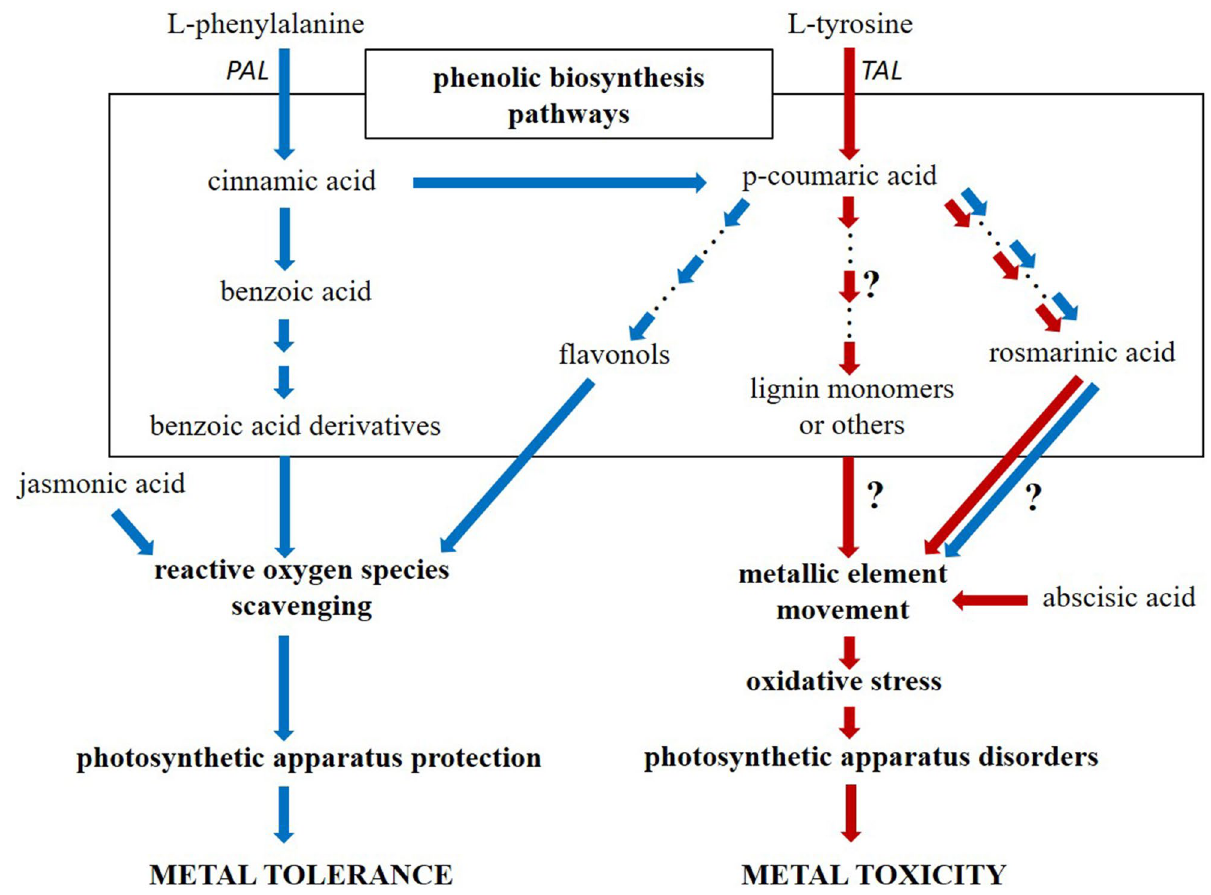
Figure 4. Schematic representation of physiological actions (bold font) leading to metal tolerance or toxicity, which result from the activation of ecotype-specific pathways of phenolic compound biosynthesis as well as different phytohormones operating in metallicolous and non-metallicolous Alyssum montanum specimens treated with Zn, Pb and Cd ions. Arrows indicate the successive stages of changes taking place in metallicolous (blue color) and non-metallicolous (red color) ecotype; arrow(s)–dots–arrow(s) suggest a long way of metabolic changes between particular compounds; question marks point to hypotheses to be tested by future work. This conceptual graph is based on the results from the present study and our previous experiments 18,26 on both